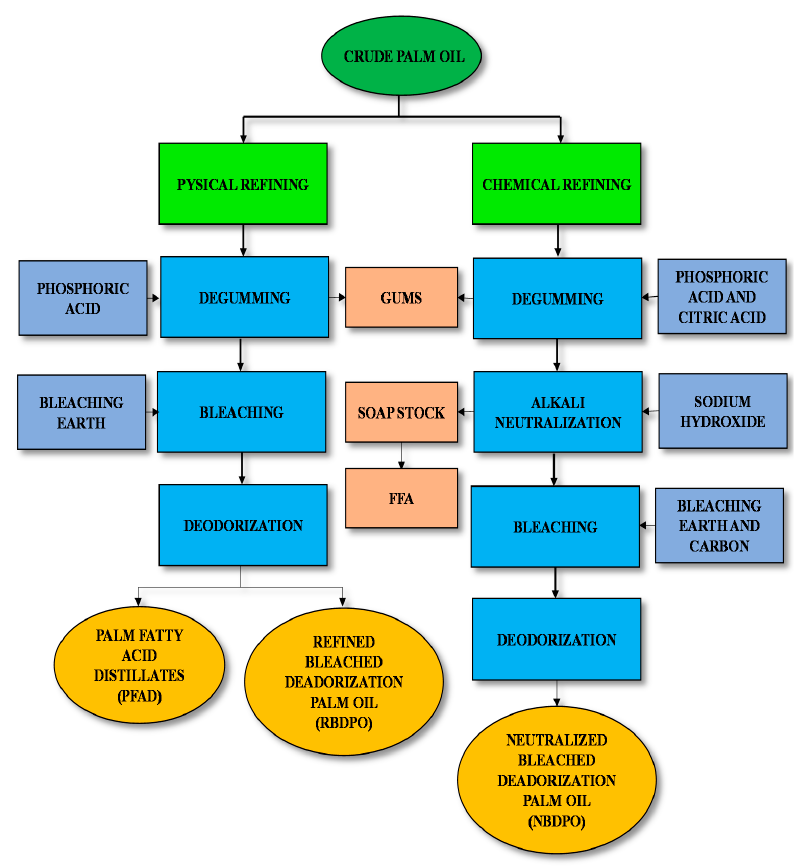
Figure 3. Chemical and physical refining process of palm oil.